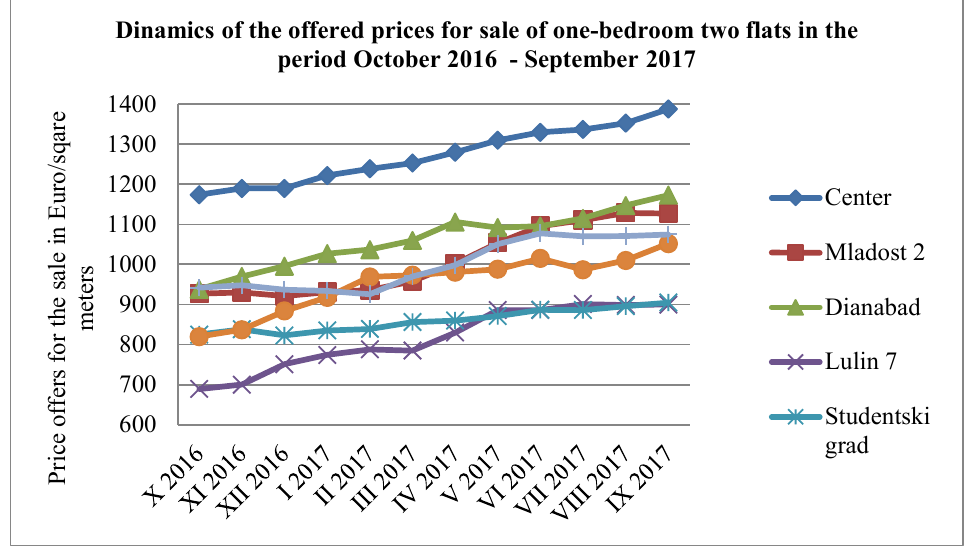
Fig. 2 . Change of the offered prices for the sale of one-bedroom flats in the period October 2016 to September 2017 for some neighbourhoods of Sofia (developed by the authors, using